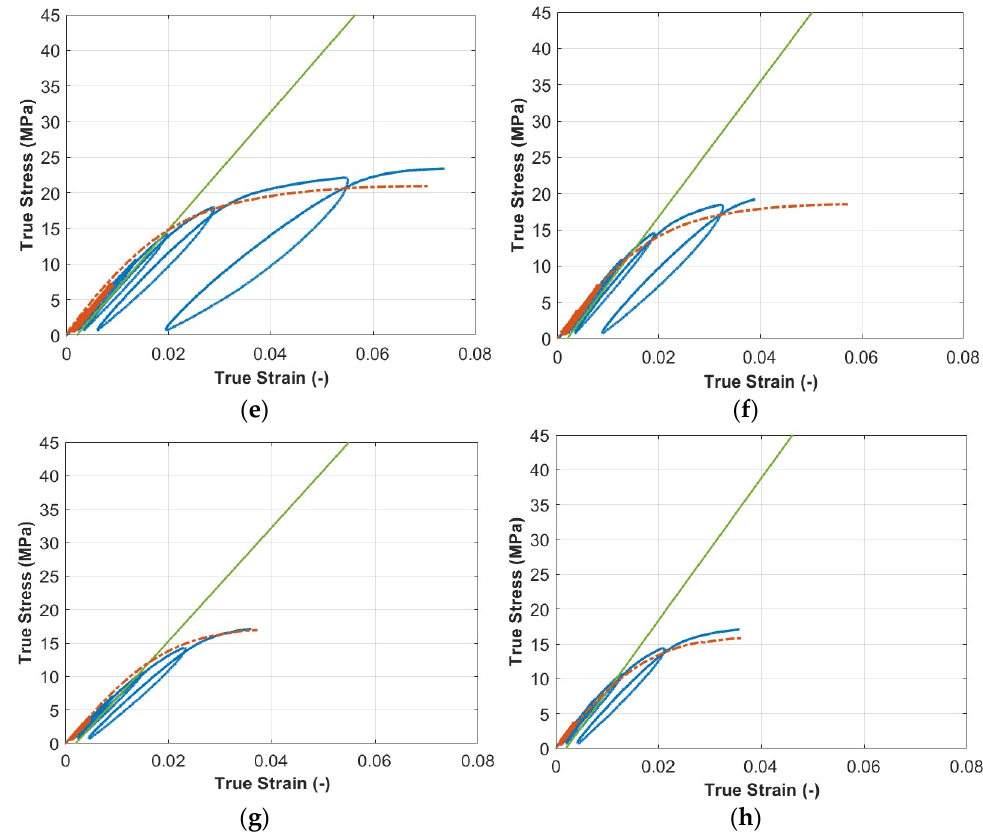
Figure 6. Stress–strain curves of cyclic tests conducted on the PL specimen ( a ), the 0° specimen ( b ), the 15° specimen ( c ), the 30° specimen ( d ), the 45° specimen ( e ), the 60° specimen ( f ), the 75° specimen ( g ), and the 90° specimen ( h ). Orange dashed curves represent monotonic stress–strain curves, while orange continuous lines represent the portion of the cyclic curve that was considered for Young’s modulus evaluation. Green lines are those used for the R p 0.2 yield stress